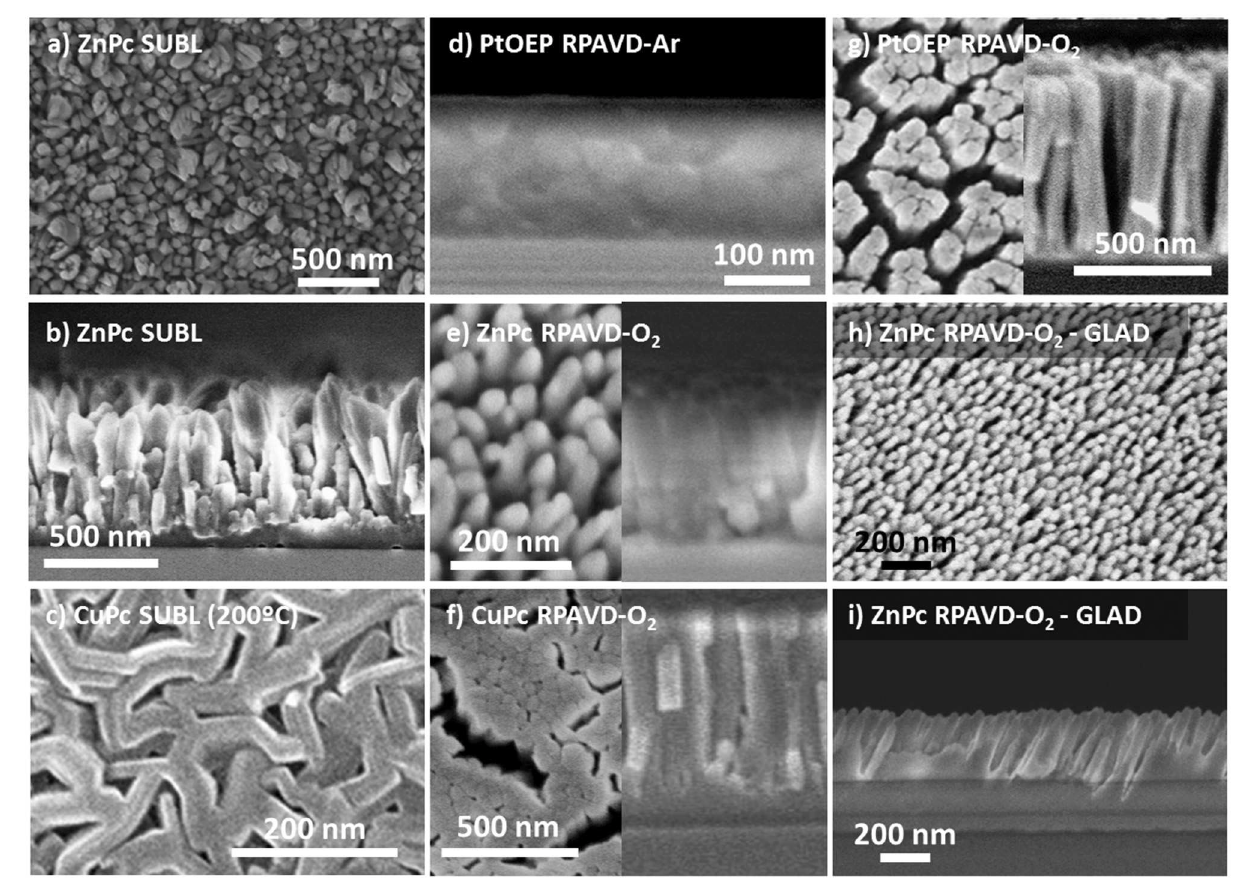
FIGURE 1 | Planar view and cross-section SEM micrographs of representative samples as labeled (see also Table 1 at the Experimental Section): (a,b) planar and cross-sections corresponding to the direct sublimation of ZnPc molecules with the substrate at room temperature; (c) Planar view of a CuPc sublimated sample with the substrate temperature at 200 ◦ C; (d) Cross-section of a sample Remote plasma assisted vacuum deposited sample of PtOEP using Ar plasma; (e–g) planar (left) and cross-section (right) views of ZnPc, CuPc, and PtOEP molecules deposited by RPAVD-O 2 ; (h,i) Planar and cross-section views of the ZnPc deposition at glancing angles supported by remote oxygen